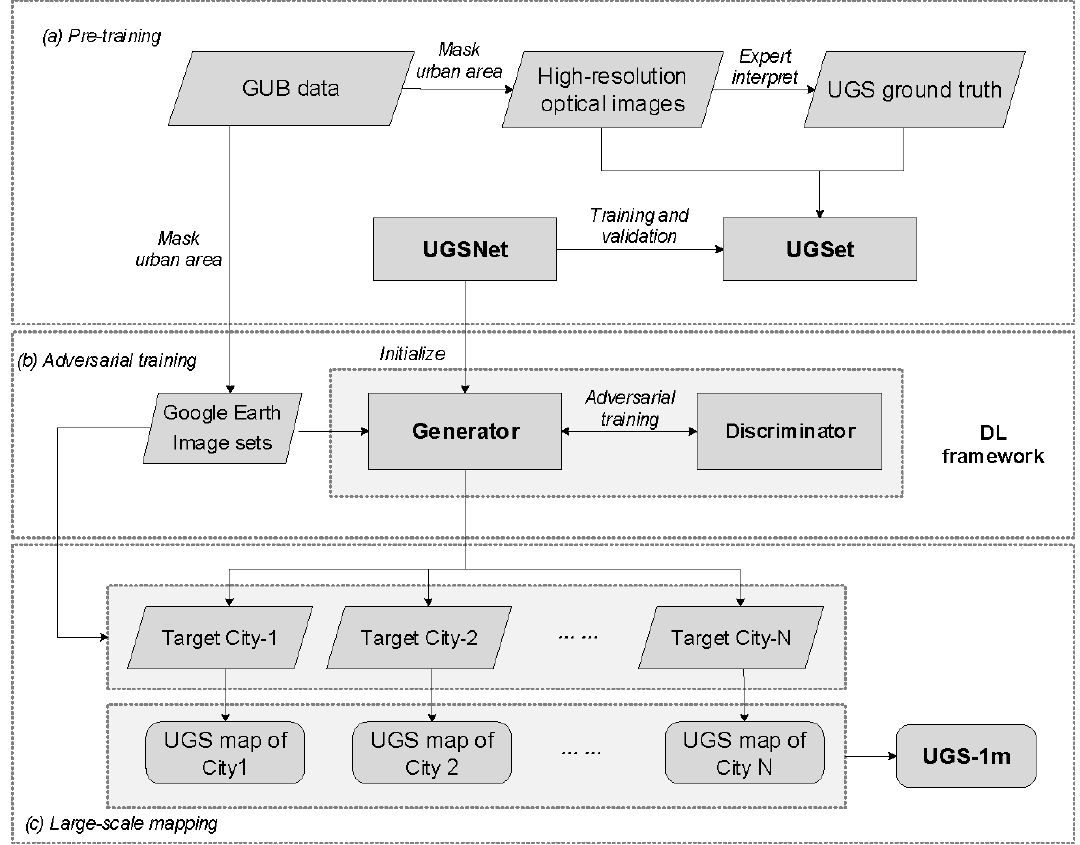
Figure 1. Diagram of the deep learning framework to generate UGS-1m. (a) Pre-train the proposed UGSNet on the UGSet dataset. (b) Op- timize the generator (initialized by UGSNet) to different target cities with a discriminator through adversarial training. (c) Apply each optimized generator to the corresponding target city for large-scale